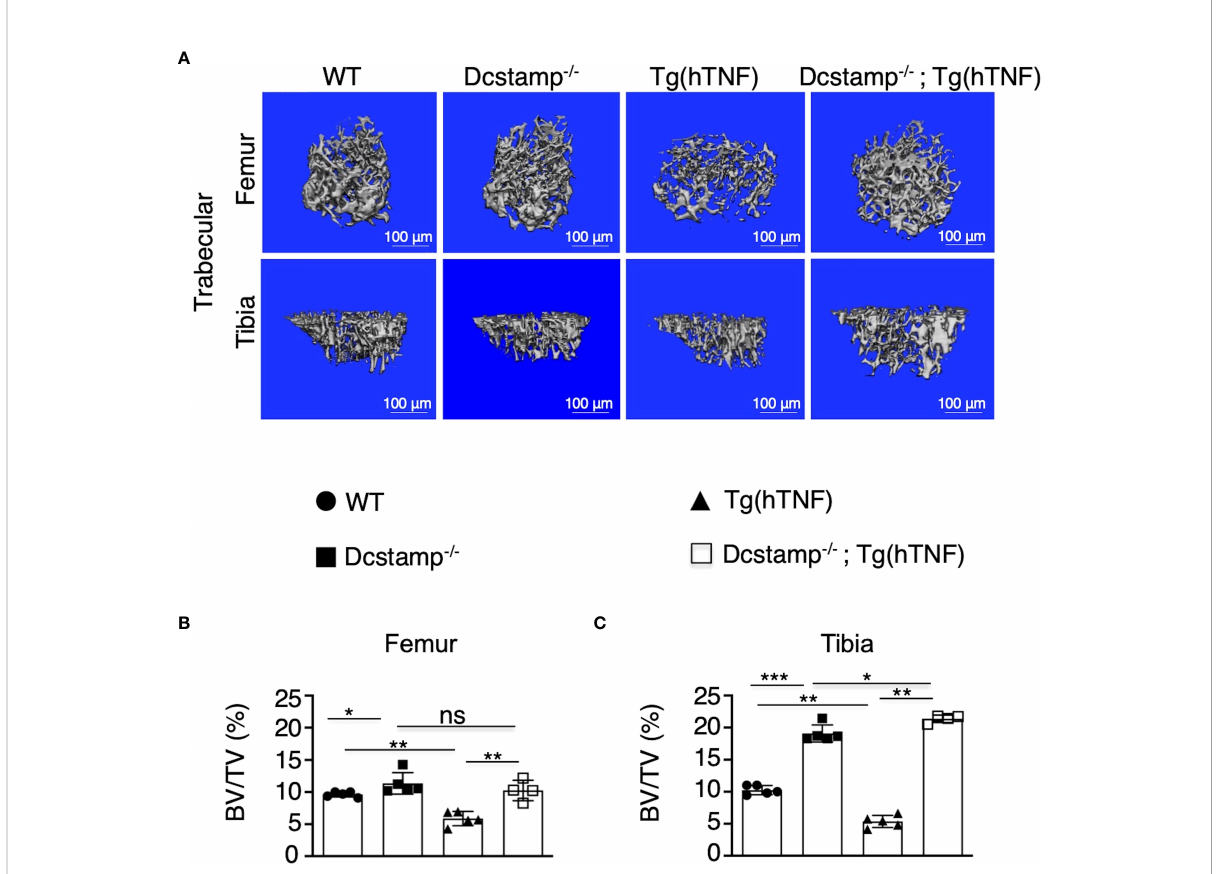
FIGURE 2 Bone density is increased in Tg(hTNF) mice lacking DC-STAMP. (A) Micro-CT images of femoral (upper) and tibial trabecular areas (bottom) of 5-month-old female mice show lower bone density in Tg(hTNF) mice compared with WT, Dcstamp -/- and Dcstamp -/- ; Tg(hTNF) mice. The percentage of bone volume in femur (B) and tibia (C) were considerably reduced in Tg(hTNF) mice. Data represent the mean ± SD. n = 4-5 mice per group/one back paw per mouse. ns, not statistically signi fi cant *p < 0.05, ** p ≤ 0.005, *** p ≤ 0.001 (Mann-Whitney test). BV/TV= bone volume